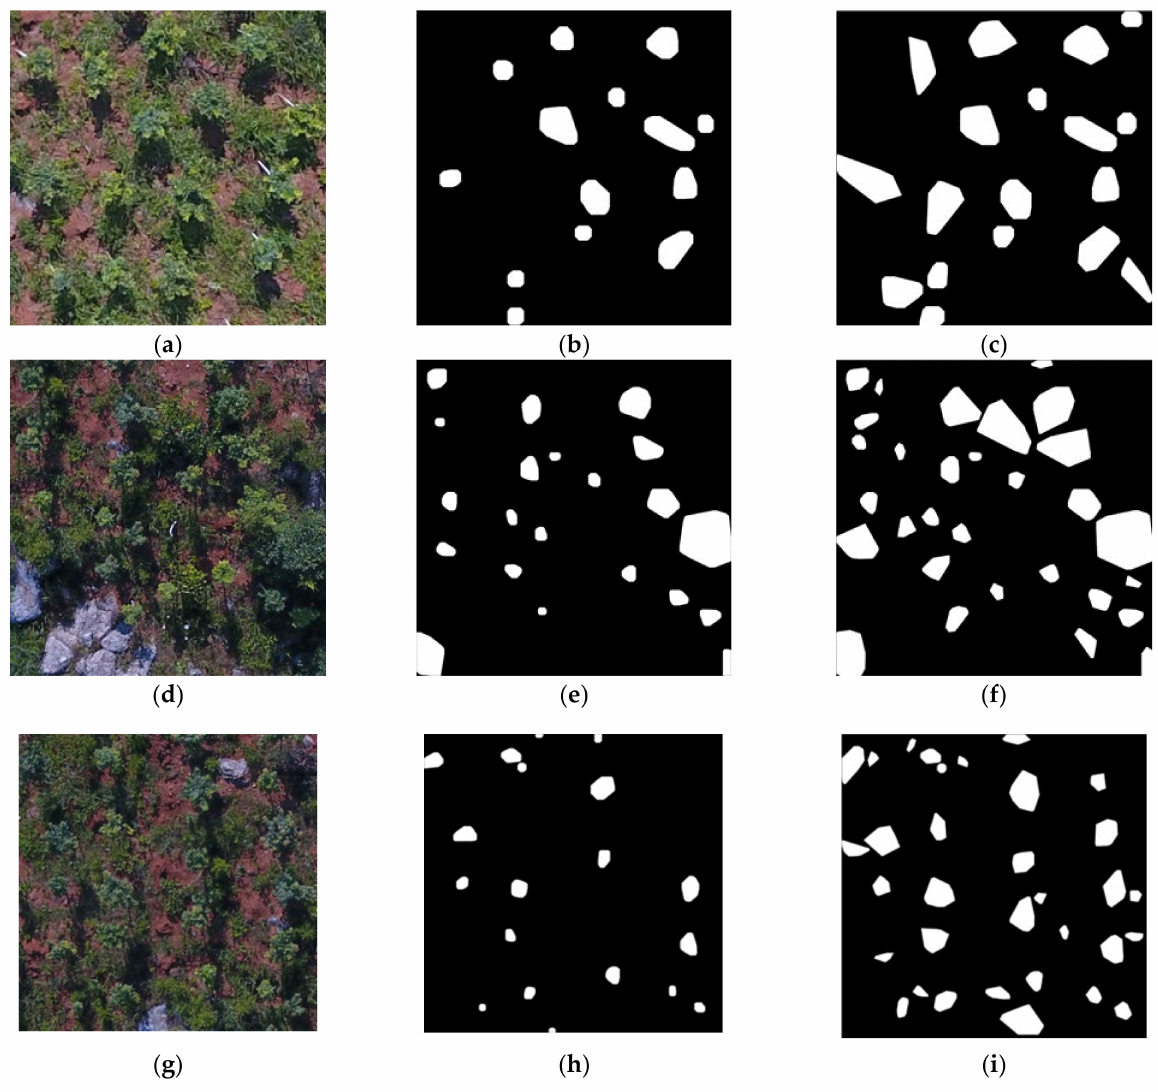
Figure 6. MREFCM results under different conditions. ( a ) An example image of HFVC and SB. ( b ) The extracted result of ( a ) with a close filter with a 3-pixel radius. ( c ) The result obtained by fusing the areas extracted of ( a ) through the four radius filters. ( d ) An example image from a 20 m height with MFVC and IB. ( e ) The extracted result of ( d ). ( f ) The fusion result of ( d ). ( g ) An example image from a 20 m height with HFVC and IB. ( h ) The extracted result of ( g ) with a 3-pixel radius. ( i ) The fusion result of ( g ) through the four radius